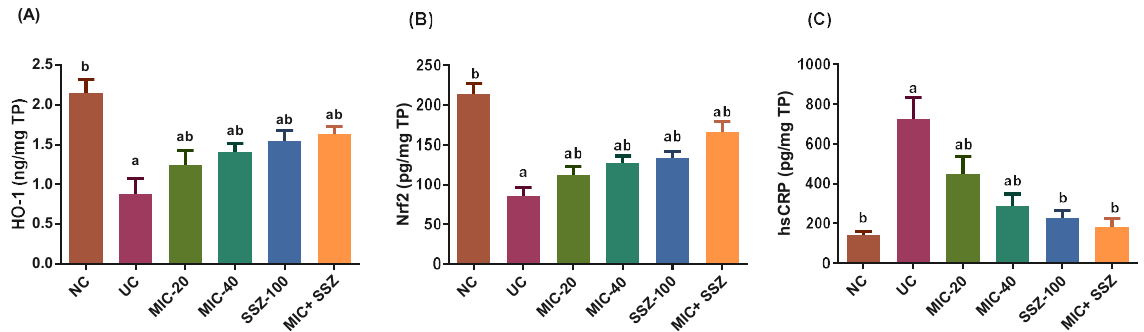
Figure 2. Effect of miconazole, sulfasalazine and their combination on Nrf2 ( A ), HO-1 ( B ) and CRP ( C ) in AA-induced UC. Each group’s values are expressed as the mean ± SEM of seven animals. a Significantly different at p ≤ 0.05 from the negative control (NC) values. b Significantly different at p ≤ 0.05 from the ulcerative colitis control (UC) values.